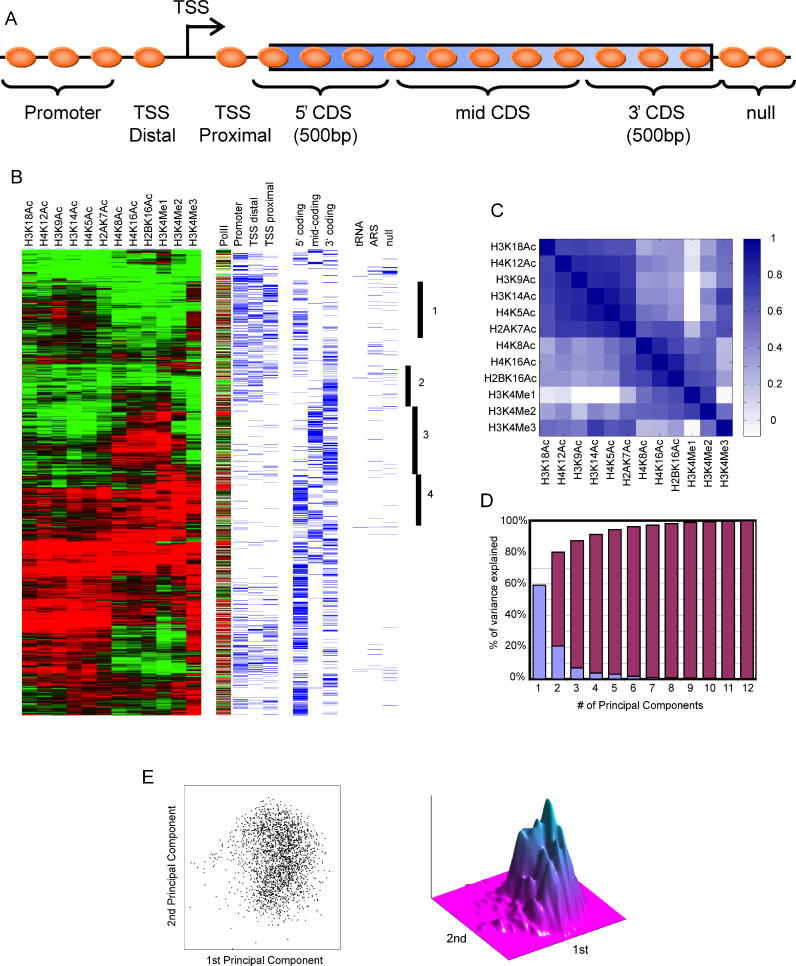
Nucleosome Modification Patterns(A) Schematic of annotation scheme for nucleosomes based on their position relative to transcribed units. Intergenic nucleosomes were assigned to the following categories: promoter region (anything upstream of a coding region), nucleosome immediately upstream to the TSS (“distal”), and the nucleosome immediately downstream of the TSS (“proximal”). Transcribed regions were separated into 5′, middle, and 3′ CDSs. Finally, to capture features of chromatin not associated with PolII genes, we independently classified nucleosomes associated with ARS sequences, tRNA genes, and Null (any other intergenic region).(B) Hierarchical clustering of 2,288 nucleosomes. Left panel: each row corresponds to a single nucleosome, and each column to a particular modification. Red (green) denotes hyper-acetylation (hypo-acetylation) in the first nine columns and relative level of methylation in the last three columns. Rows are sorted according to the dendogram built during clustering. PolII shows the PolII occupancy of the gene associated with the nucleosome in question. Right panel: each row corresponds to a nucleosome (matching the left panel), and each column corresponds to an annotation of the nucleosome according to the scheme of (A). A blue cell denotes a positive annotation of the nucleosome with the appropriate column label. Numbers indicate examples of clusters, as follows: (1) nucleosomes enriched for H3K9Ac, H3K14Ac, and H3K4Me3 that are mostly upstream of transcribed regions; (2) strongly hypo-acetylated nucleosomes, mostly at upstream regions or 3′ of coding regions; (3) nucleosomes acetylated at H4K8 and K16, and H2B K16 that are almost exclusively at the middle and 3′-ends of coding regions; and (4) hyper-acetylated and methylated nucleosomes that are mostly found at the 5′-end of coding regions.(C) The Pearson correlations of the 12 modification levels between different probes show that there are two tightly correlated groups of acetylations at specific residues. The first group consists of H2A K7; H3K9, K14, and K18; and H4K5 and K12. The second group consists of H2B K16; and H4K8 and K16. Mono- and di-methylation of H3K4 are correlated with the second group, while tri-methylation of H3K4 is correlated with the first group.(D) The percent of variance captured by using different number of components. The x-axis denotes the number of components, and the y-axis denotes the percent of the variance in the data explained by each components (blue bars) as well as the cumulative percentage explained (red bars).(E) Representation of all nucleosomes in two-dimensional modification space. In the left panel, each point represents a nucleosome plotted according to the relative level of the first principal component (x-axis) and second principal component (y-axis) for the modification pattern. The right panel is a three-dimensional plot showing density of points along the plane.